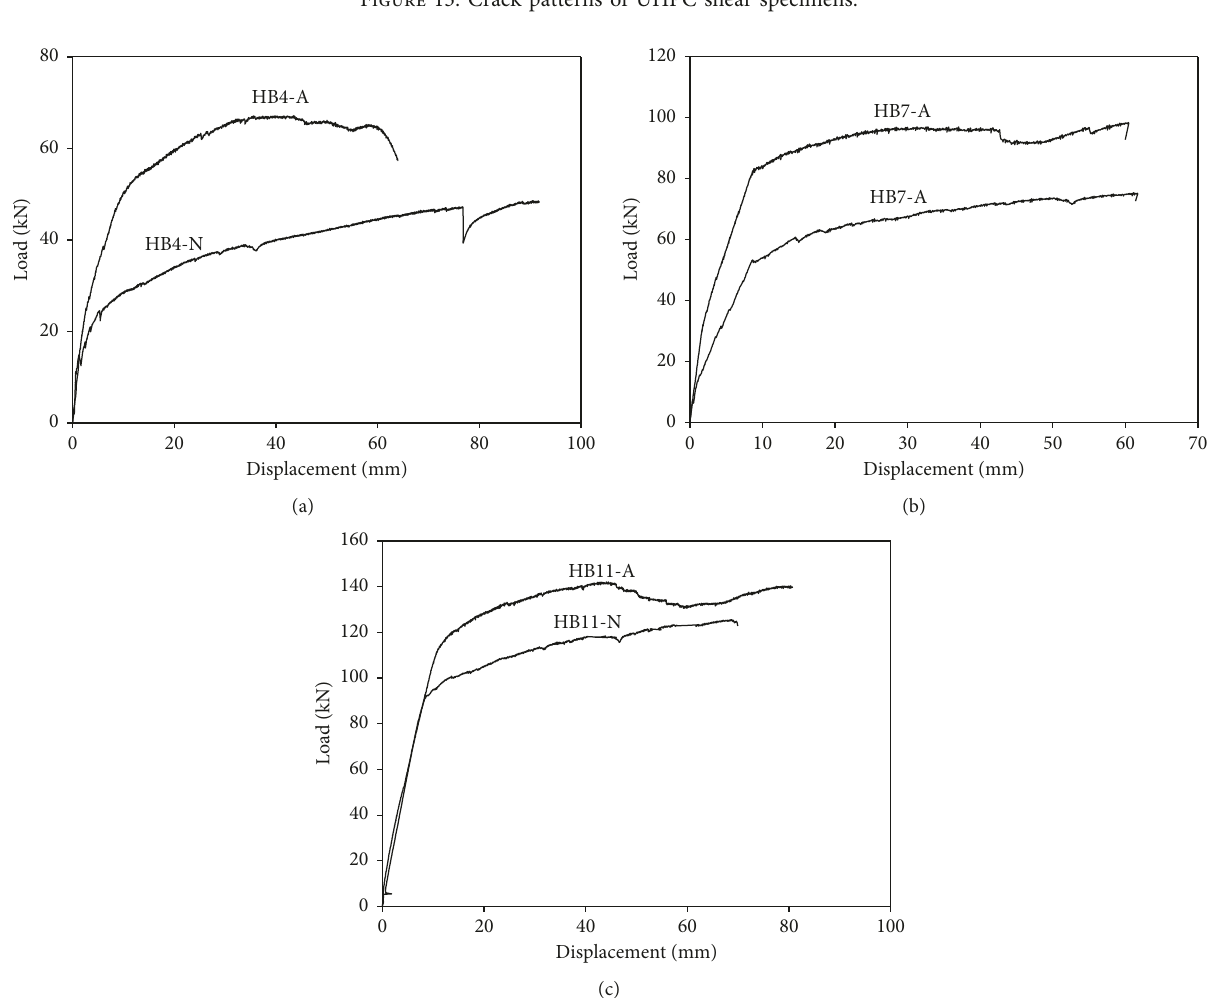
Figure 13: Crack patterns of UHPC shear specimens.